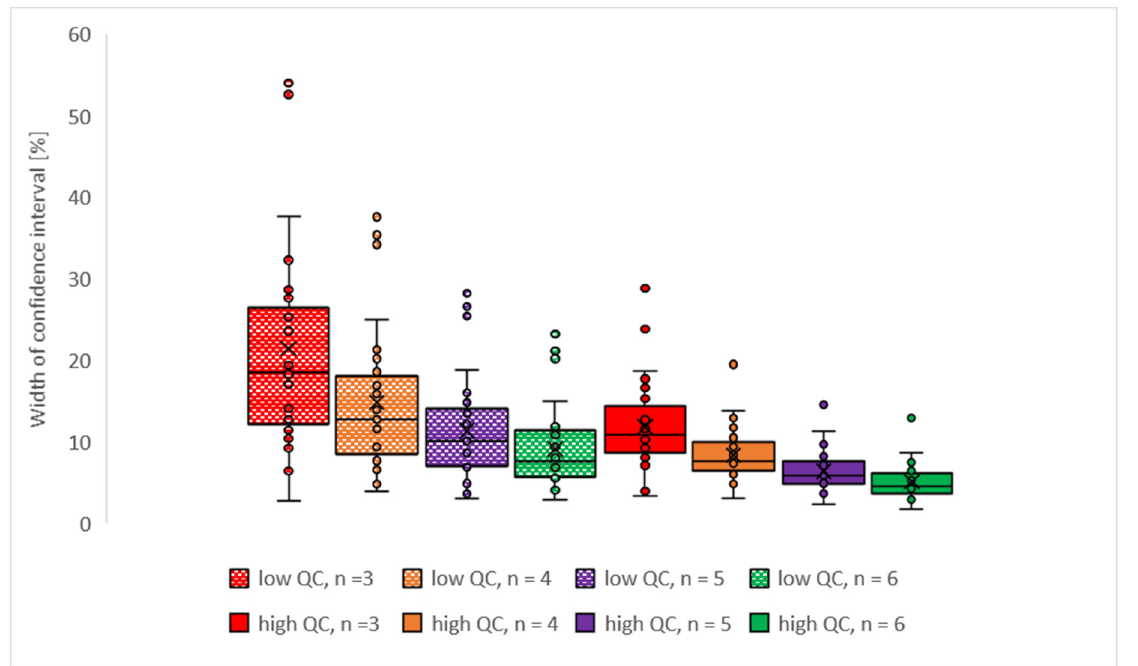
Figure A4. Retrospective study: box & whiskers plot; box indicates 2nd and 3rd quartile, whiskers indicate 1st and 4th quartile, points outside of whiskers indicate outliers.